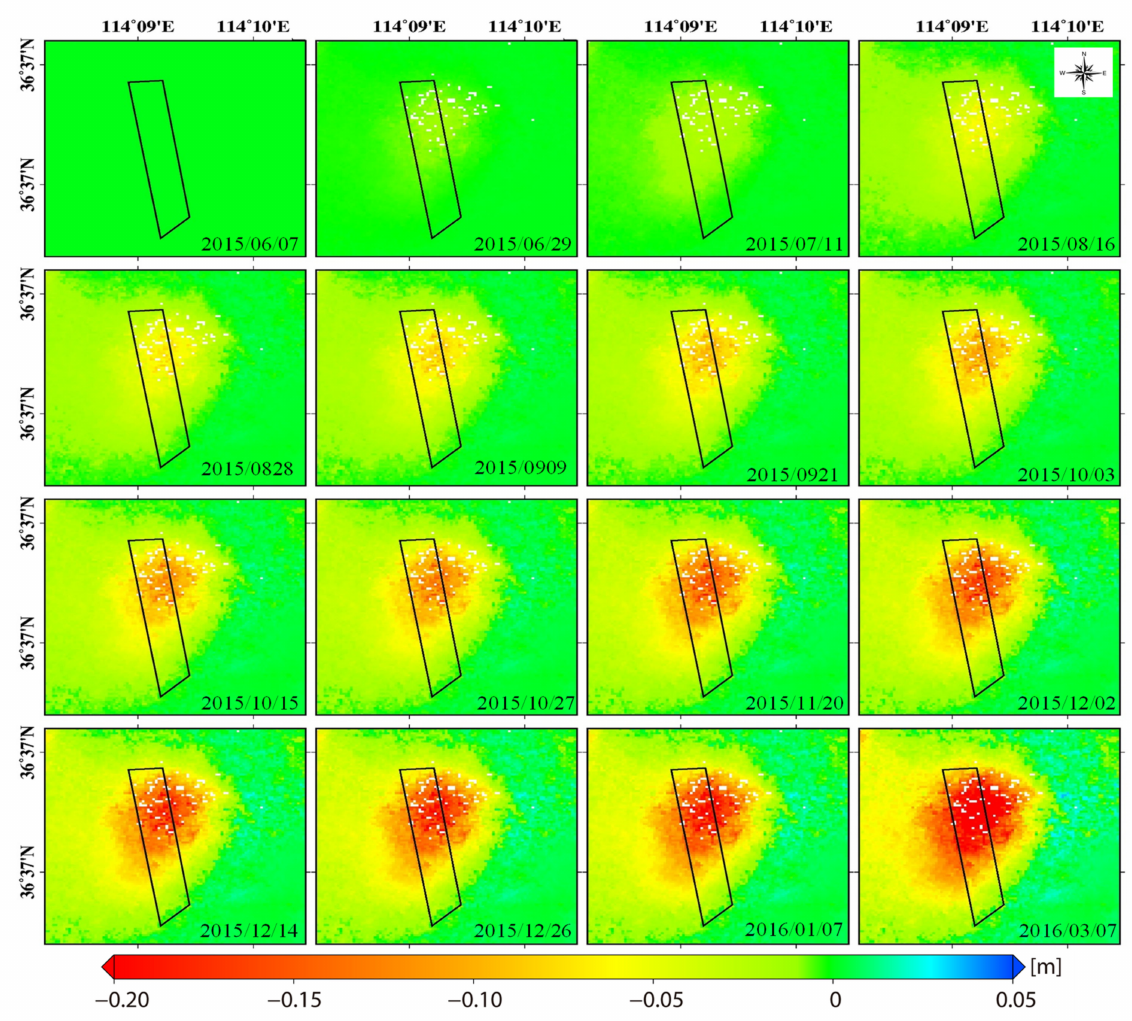
Figure 7. Time series of cumulative deformation. The black polygon represents the 132,610 working